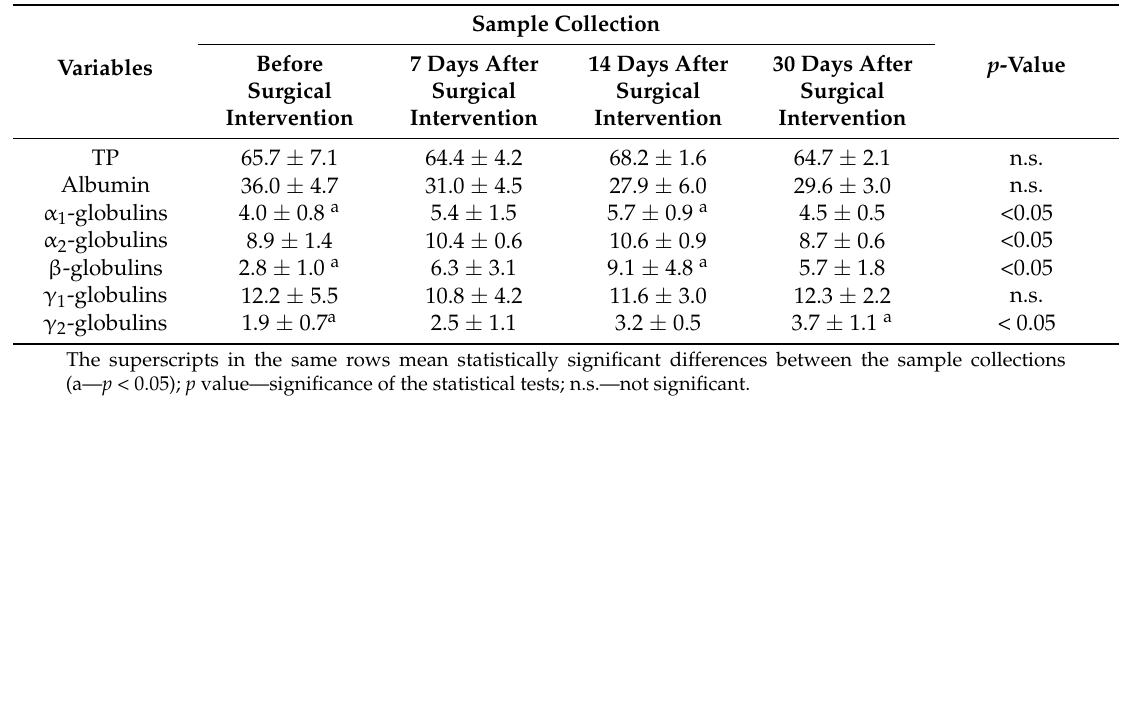
Table 2. Changes in the absolute concentrations of total serum protein (TP), and protein fractions (g/L) in sheep before surgical intervention and in the postoperative period (mean ±